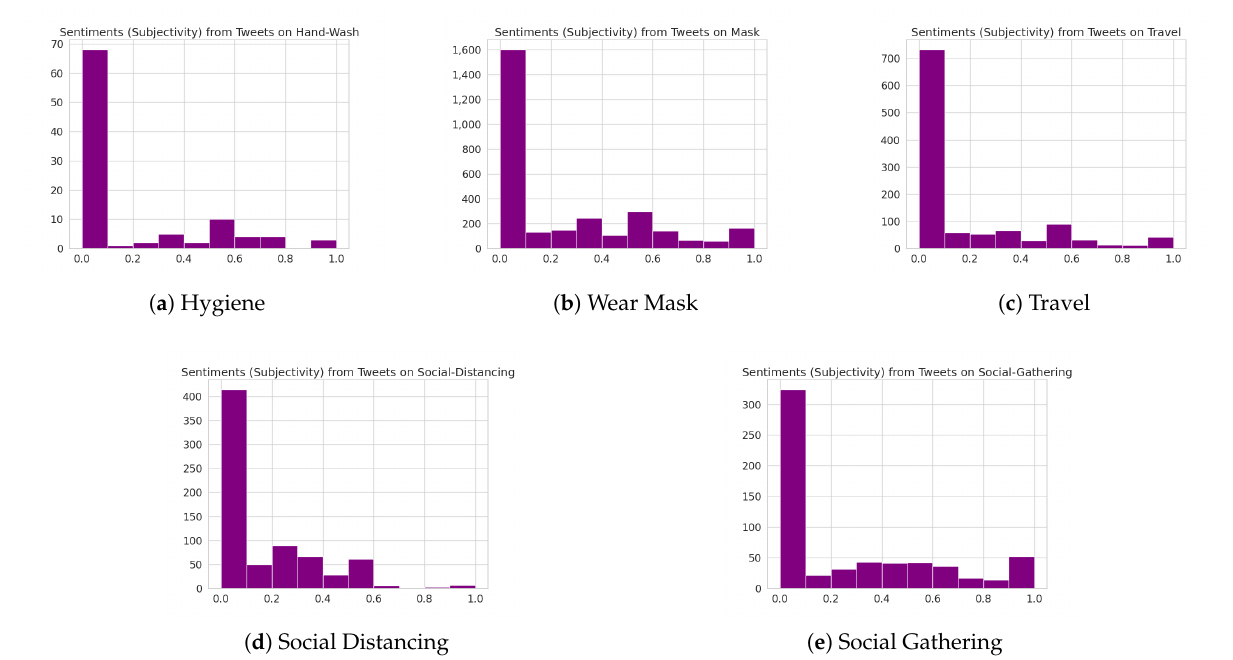
Figure A5. Subjectivity score of public sentiment for Twitter Dataset 2 on health. VersionJune7,2021submittedto Appl. Sci.